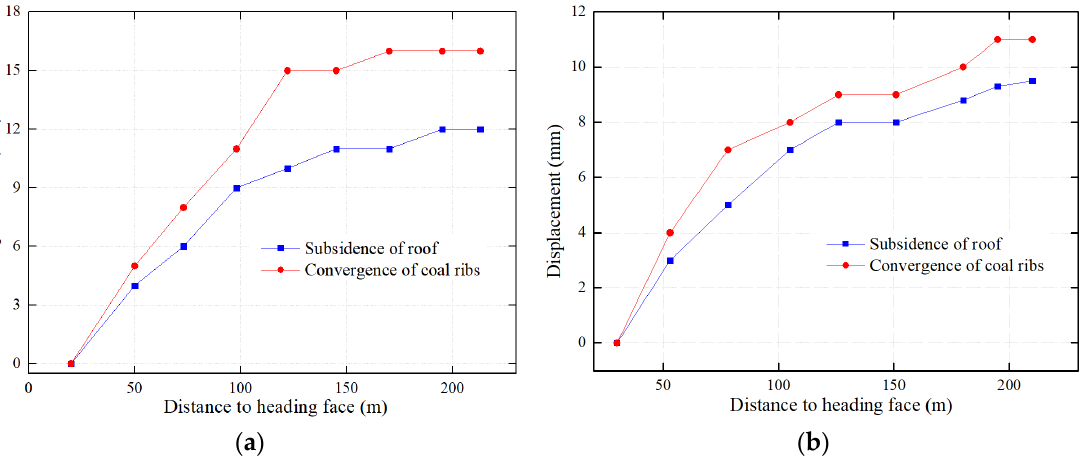
Figure 13. Surface displacement law of the roadway under the new supporting technology: ( a ) monitoring results of monitoring station 1; ( b ) monitoring results of monitoring station 2.